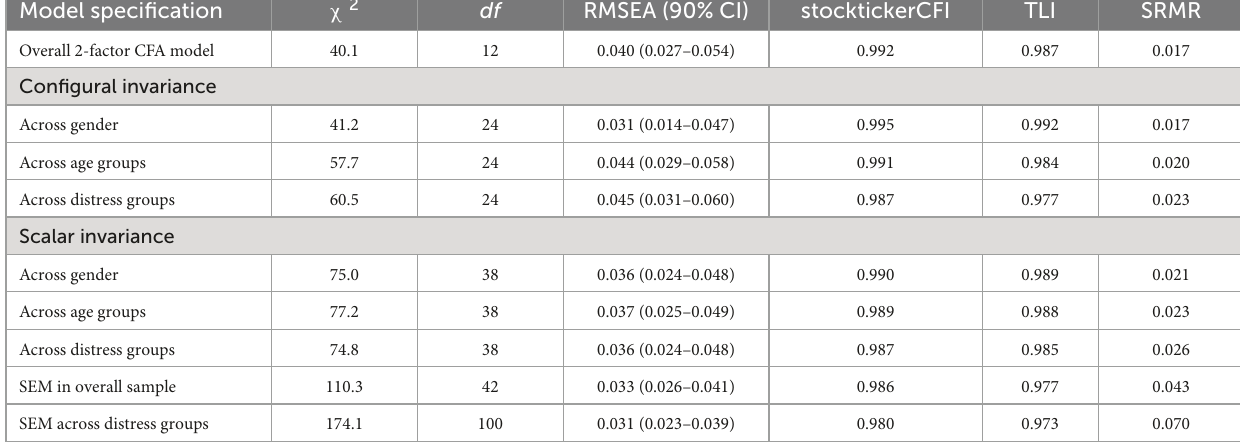
TABLE 2 Fit indices of CFA and SEM of meaning in life and Patient Health Questionnaire-4 in the overall sample and across subgroups. Model specification